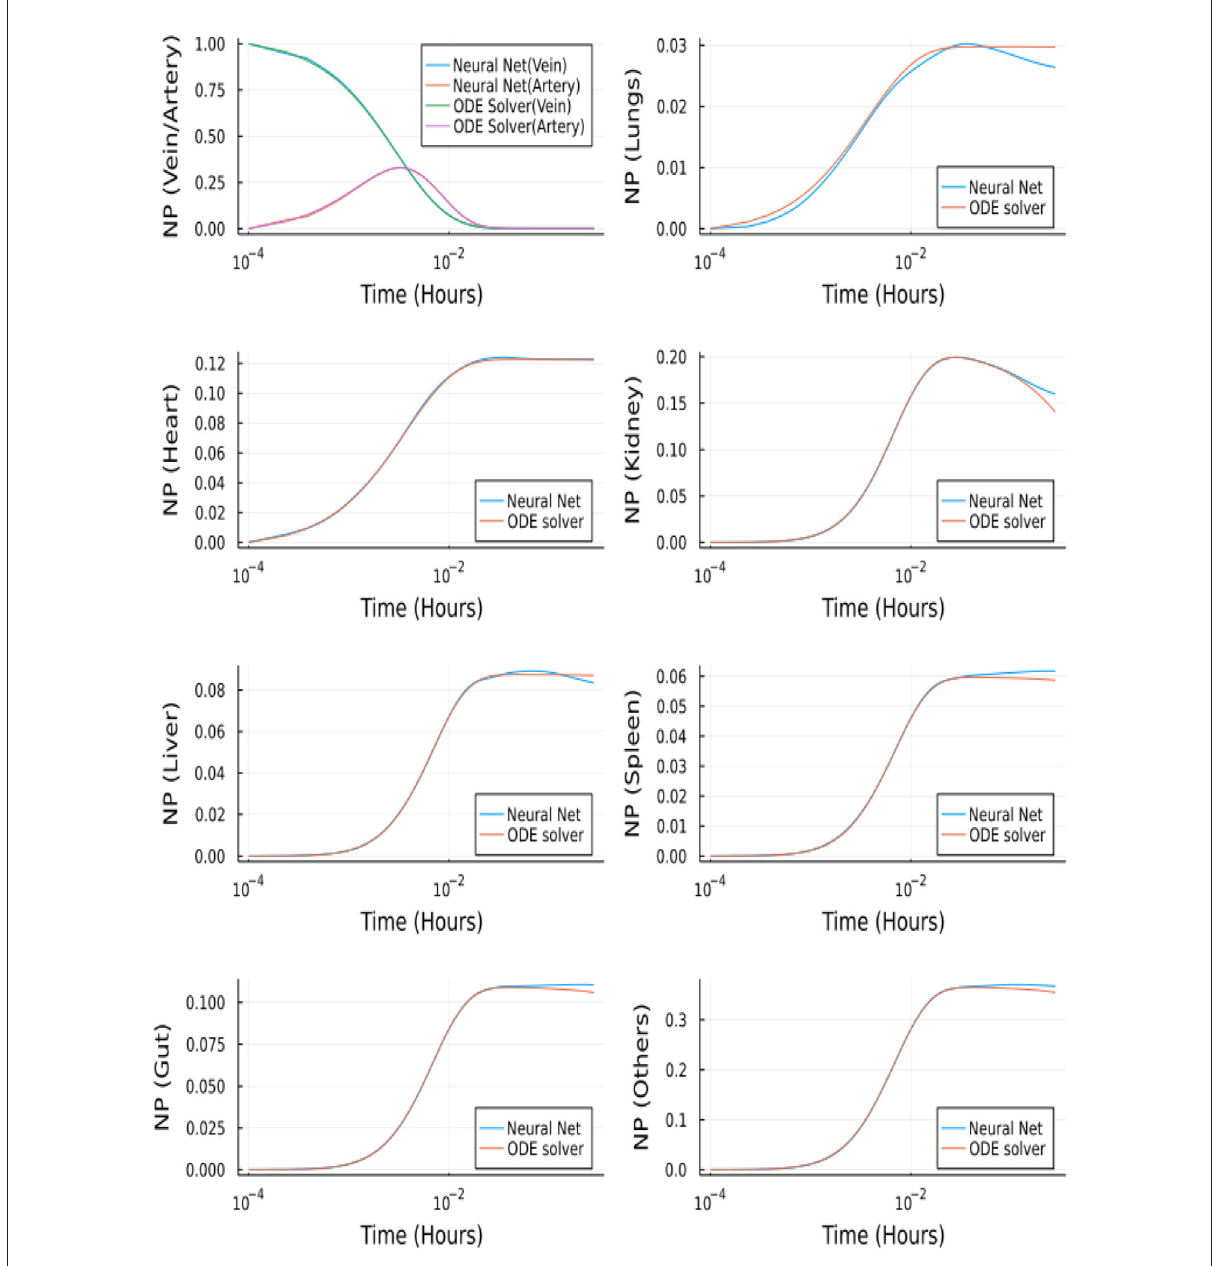
FIGURE14 Comparison between Neural Networks and Tsit5 with QSSA for unbranched model.